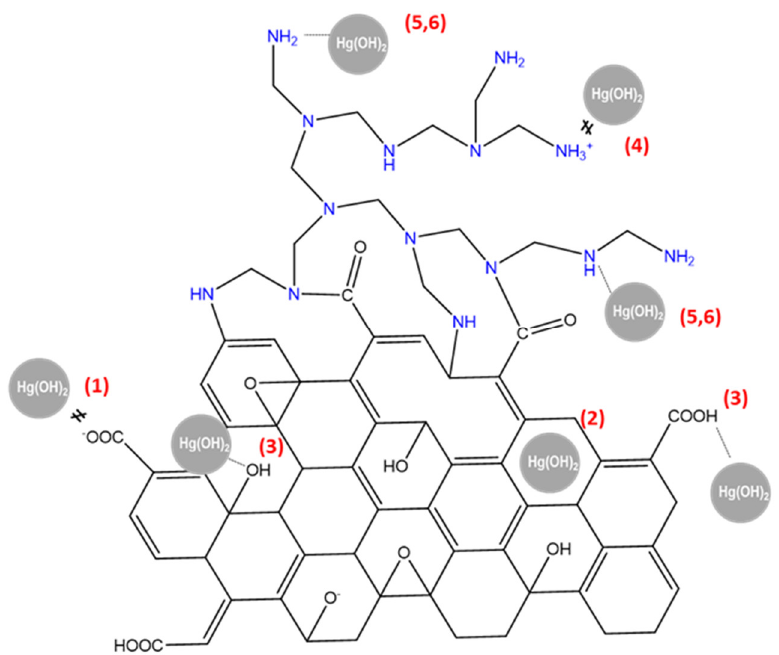
Figure 5. A schematic representation of the possible interactions represented in reactions (1–6). rGO displayed a highly negative zeta potential, ascribed to the still remaining high density of deprotonated hydroxyl and carboxyl functionalities on its surface. Electrostatic interactions between these oxygenated functionalities and the neutral Hg(OH) 2 would not occur (reaction (1)), although it can be established with the residual positively charged cations. Moreover, rGO can formally act as a Lewis base in the sense that the aromatic rings in the structure can donate electrons to form a coordination bond. Hence, acid–basic interactions can be established between rGO and the soft acid bivalent mercury (reaction (2)). Finally, hydrogen bonding between the carboxyl and hydroxyl functionalities and neutral Hg(OH) 2 is also a feasible interaction mechanism (reaction (3)). In contrast to rGO, the rGO/PEI sorbent displayed a positive or negative zeta potential value as a function of pH, with a zero-point charge observed at a pH of ca. 4. Above this pH, the charge of the sorbent was negative, given by an excess of oxygenated functionalities in rGO, and posi- tive below the same, given by an excess of protonated amino-rich functionalities in PEI. In fact, the working pH of 4.5 is close to the point of zero charge, signifying that the surface charge of rGO/PEI should be relatively neutral, with the amine functionalities protonated only to a short extent, minimizing the electrostatic interactions (reaction (4)). Ahead of the interactions established with the rGO component, primary, secondary, and tertiary forms of amine, present in rGO/PEI, have a lone pair of electrons acting as a Lewis base prone for complexation with mercury (reaction (5)); and primary and secondary amines can be hydrogen bonded to neutral Hg(OH) 2 (reaction (6)). For rGO, the binding mechanism is likely to be represented by the intermolecular interactions displayed in reactions (2,3), while for rGO/PEI, the amine-rich functionalities should be the main sorption sites (reac- tions (5,6)). 2.5. Design of Magnetic Sorbents The water stability of rGO/PEI was studied through its regeneration and potential reuse in several Hg(II) sorption cycles. It is worth mentioning that the capacity of regen- eration of this type of sorbent has already been demonstrated in a previous work for a similar GOPEI composite [20]. This type of material is easily regenerated by treating them with diluted HNO 3 (2 v%). In this way, the pH of the medium is decreased and the cationic forms of mercury (Hg 2+ and Hg(OH) + ) become predominant. The affinity of these forms